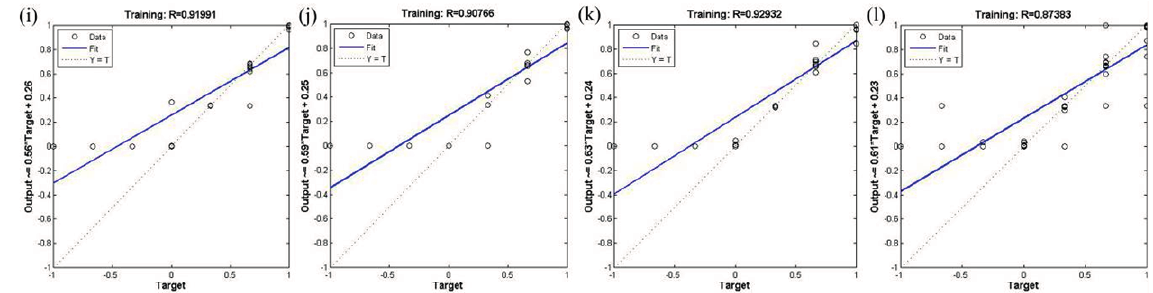
Figure 1. Validation of the BP-ANN model using the trainlm optimization algorithm. The 12 monitoring stations are as follows: ( a ) high-voltage switchgear plant; ( b ) xingqing district; ( c ) the textile city; ( d ) hamlet; ( e ) people’s stadium; ( f ) new district; ( g ) economic development zone; ( h ) chang’an district; ( i ) lintong district; ( j ) qujiang district; ( k ) guangyuntan; ( l ) marsh.